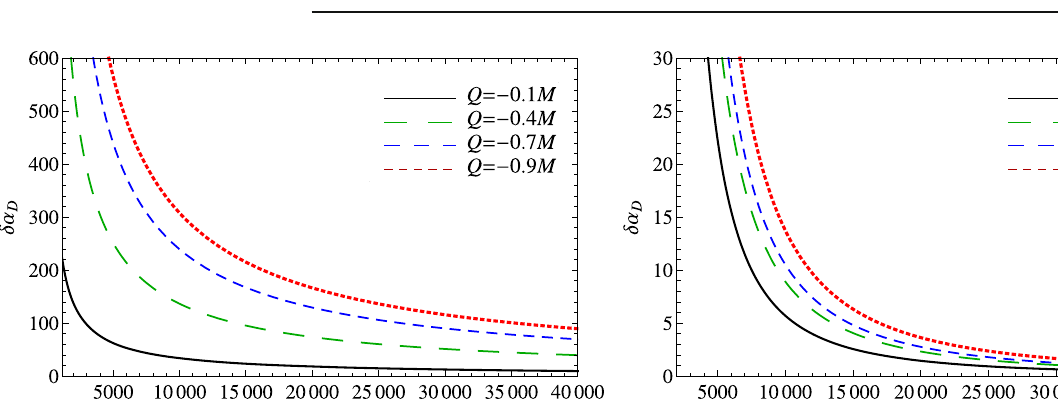
| δα = α − α D D D with NR